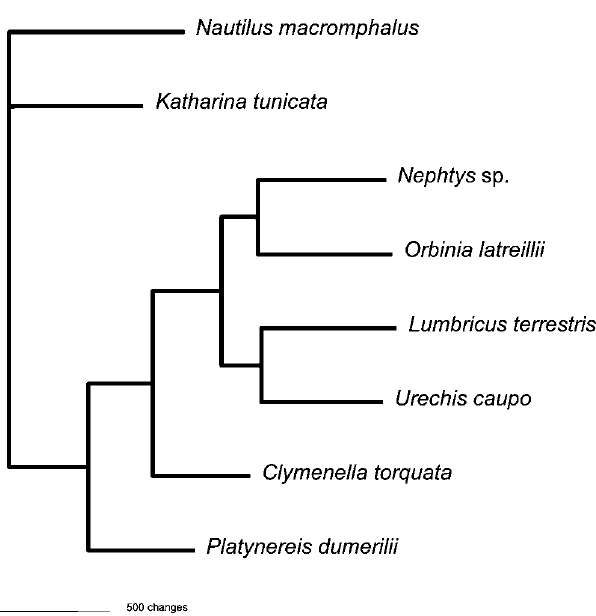
Figure 3. Maximum likelihood analysis of the protein coding genes. The maximum likelihood analysis of the mitochondrial protein coding genes of six annelids shows that branch lengths among them are similar, suggesting that Nephtys does not have an obviously slower rate that might create a propensity for harboring introns.